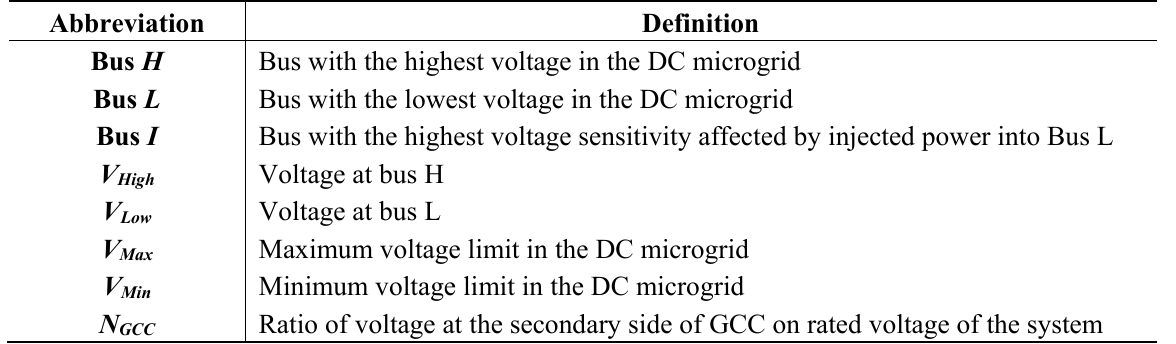
Table 1. Definition of the abbreviation in an optimal DG allocation